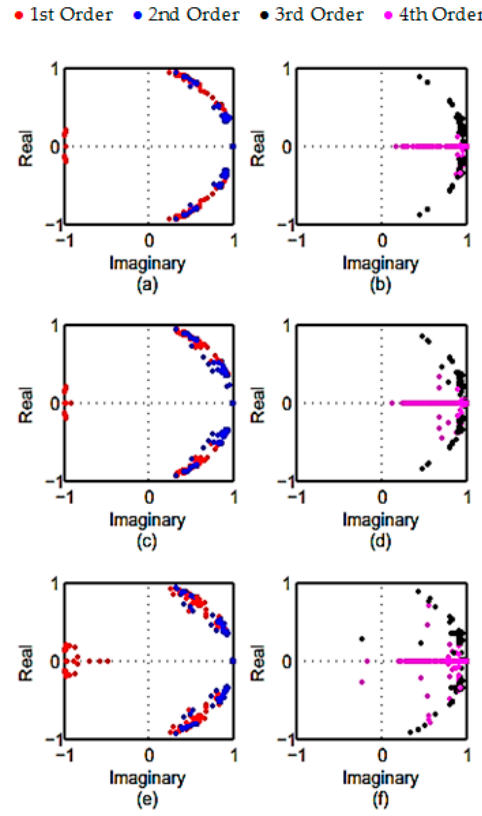
Figure 10. The estimated poles of the numerical model for: ( a ) 1st and 2nd and ( b ) 3rd and 4th orders in PC algorithm. ( c ) 1st and 2nd and ( d ) 3rd and 4th orders in UPC algorithm. ( e ) 1st and 2nd and ( f ) 3rd and 4th orders in CVA